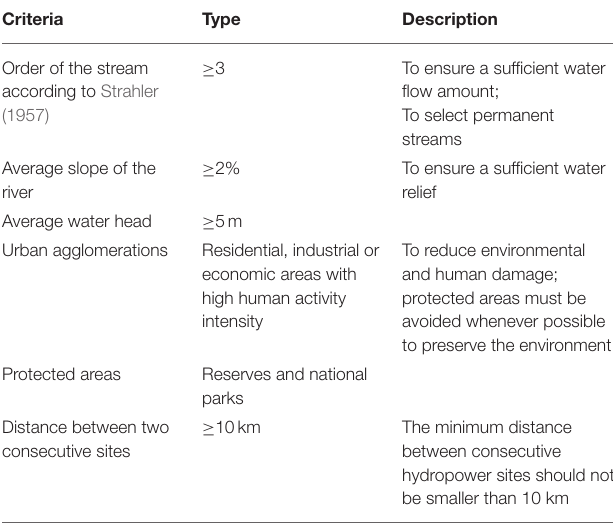
TABLE 2 | List of the restriction criteria for hydropower potential evaluation.